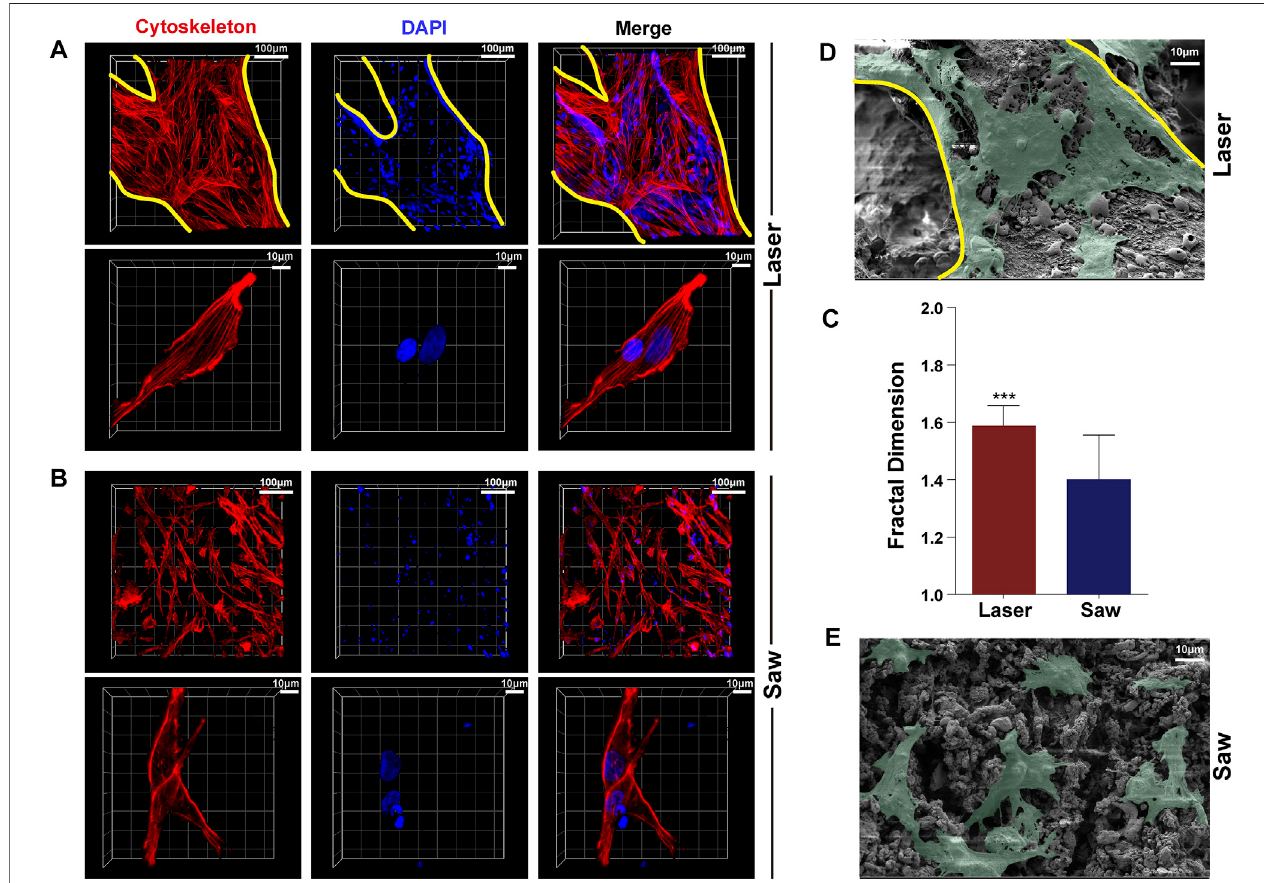
FIGURE 7 | Typical images of adhesion of MSCs. (A) is the laser group, (B) is the mechanical saw group, photographed by using a laser confocal scanning microscope, and red represents the cytoskeleton, blue represents the nucleus, and the yellow line represents the trabecular boundary. (C) Statistics of the fractal dimension of a single MSC cytoskeleton of the two groups ( n = 50) (D,E) are scanning electron microscopy images of MSC adhesion to the bone surface of the two groups (green).